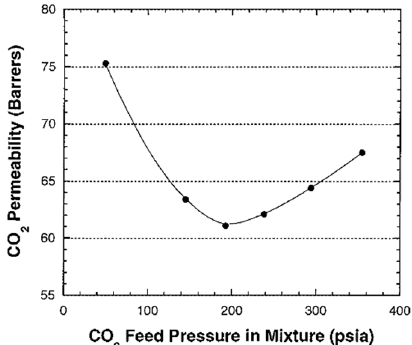
Figure 3. Mixed gas separation characteristics for 6FDA-6FpDA using 50:50 CO 2 /CH 4 mixtures at 35